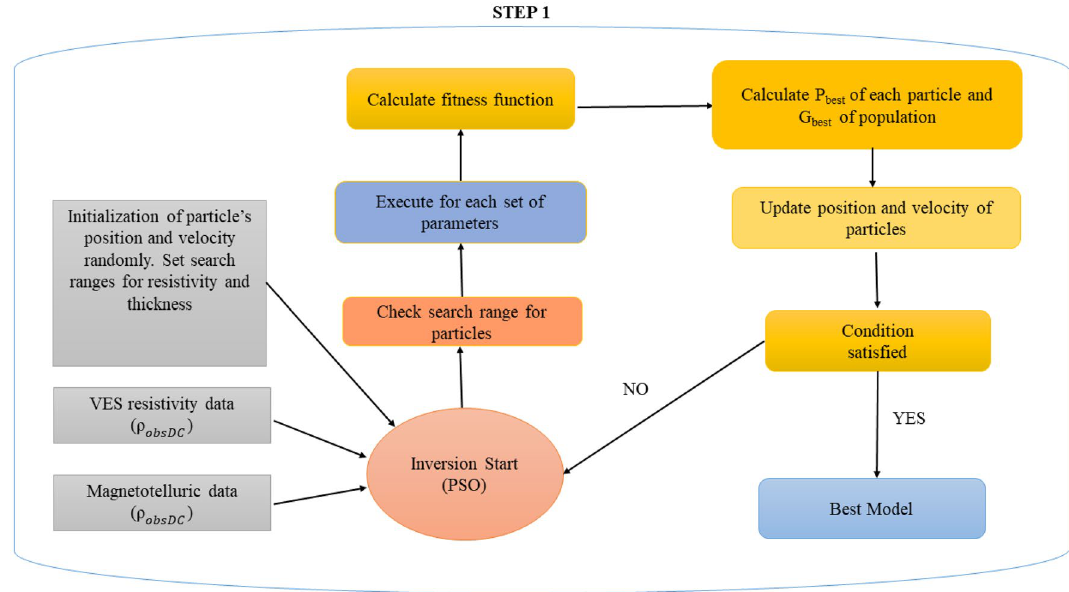
Figure 1. A schematic flow diagram depicts the procedures for individual and joint inversion of DC and MT data-based Particle Swarm